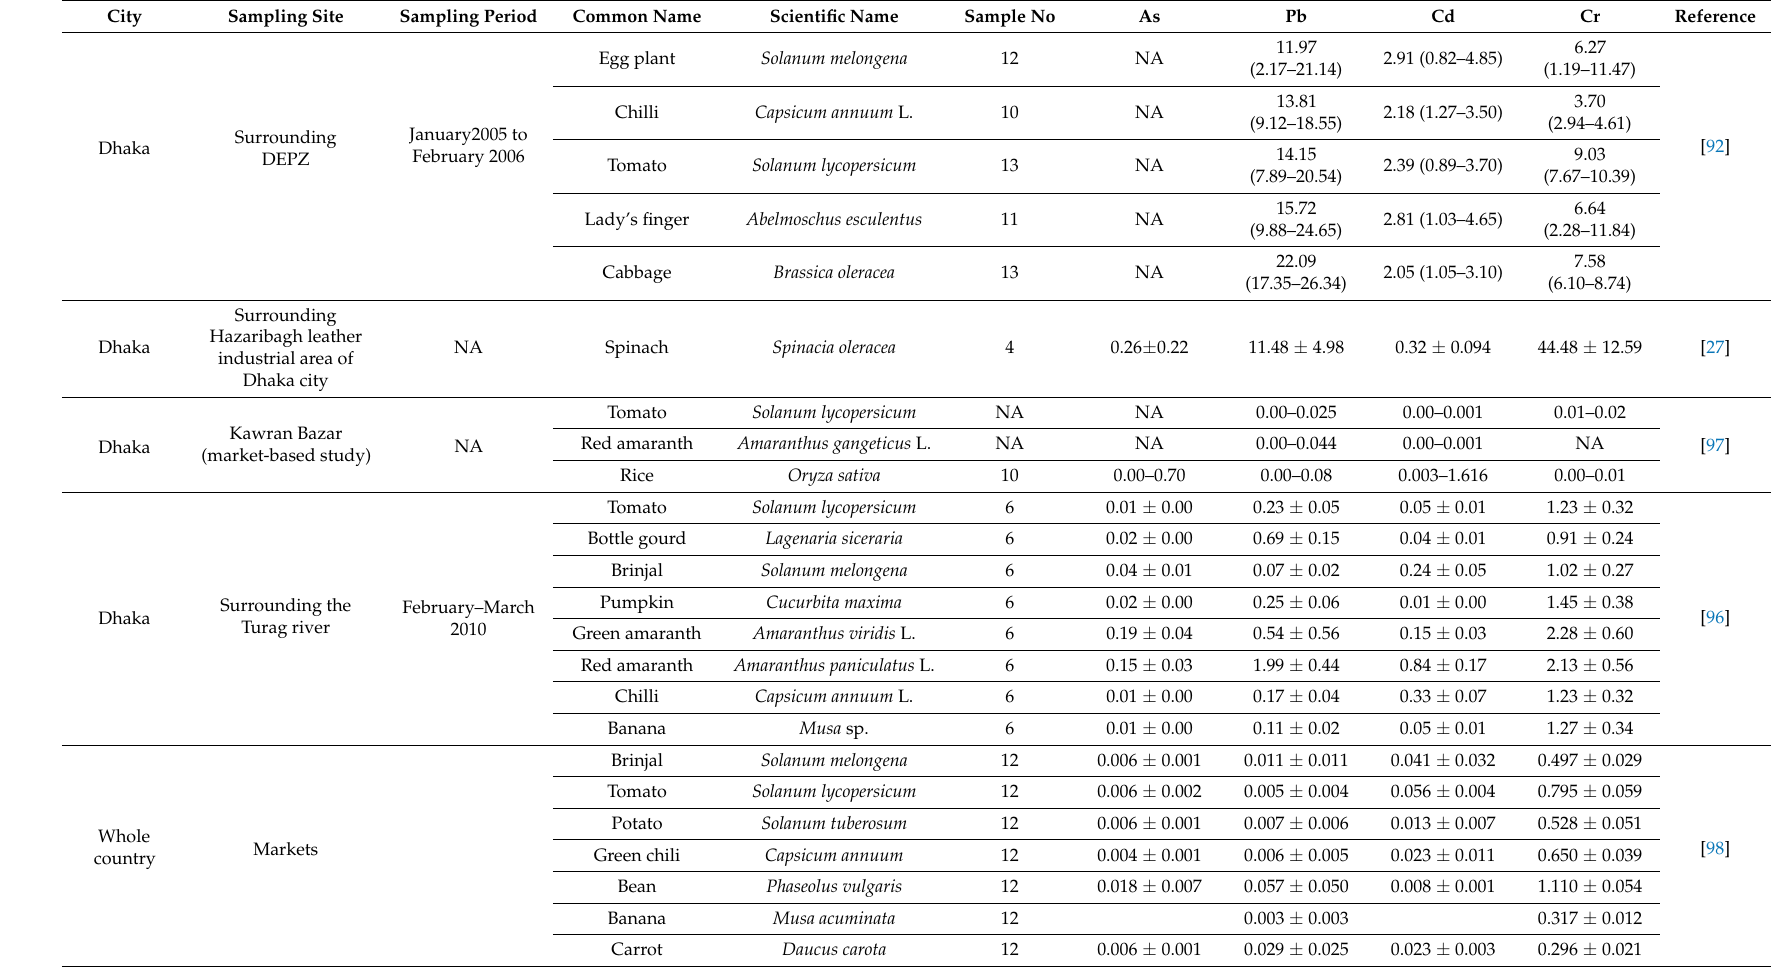
Table 5. Heavy metal and metalloid pollution in vegetables and rice